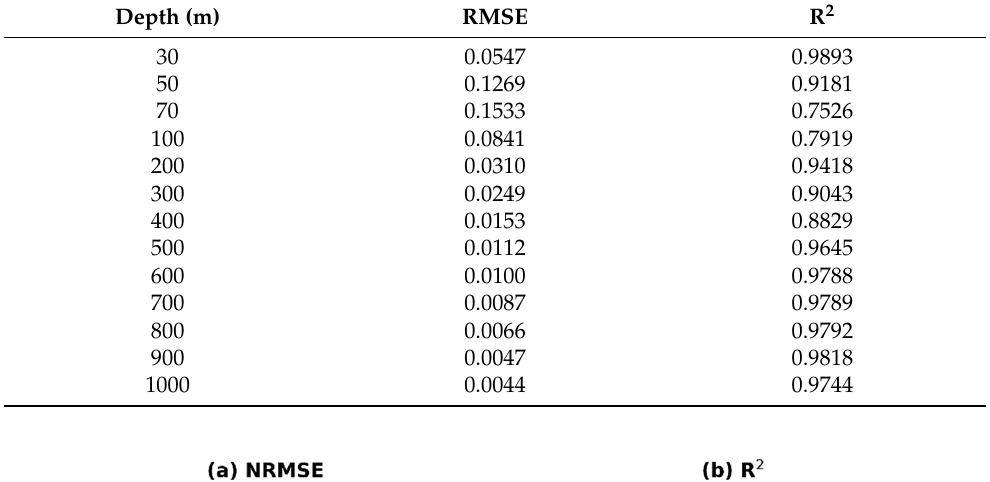
Table 2. Vertical distributions of RMSE (psu) and R 2 for the LGB-DF model at different depths in 2019.